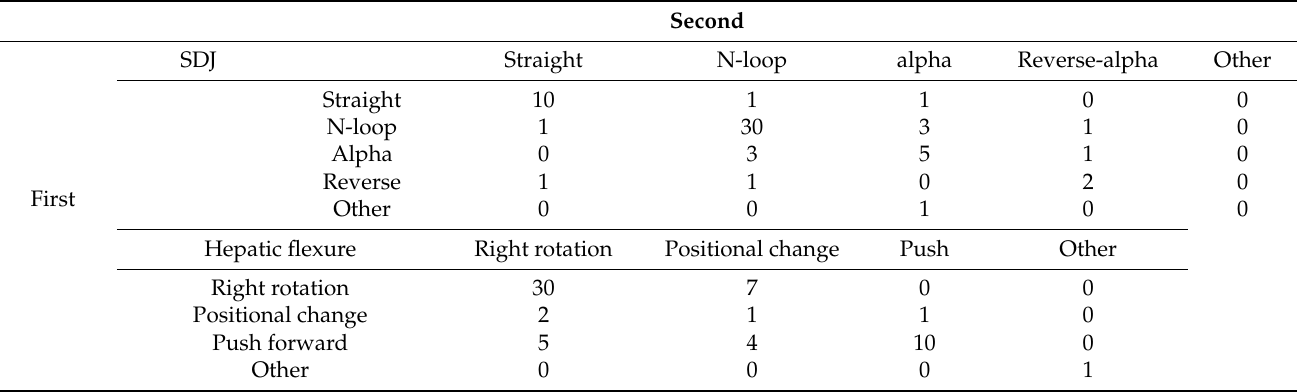
Table 1. Number of patterns for passing through the sigmoid/descending colon junction and hepatic flexure in the first and second colonoscopy.